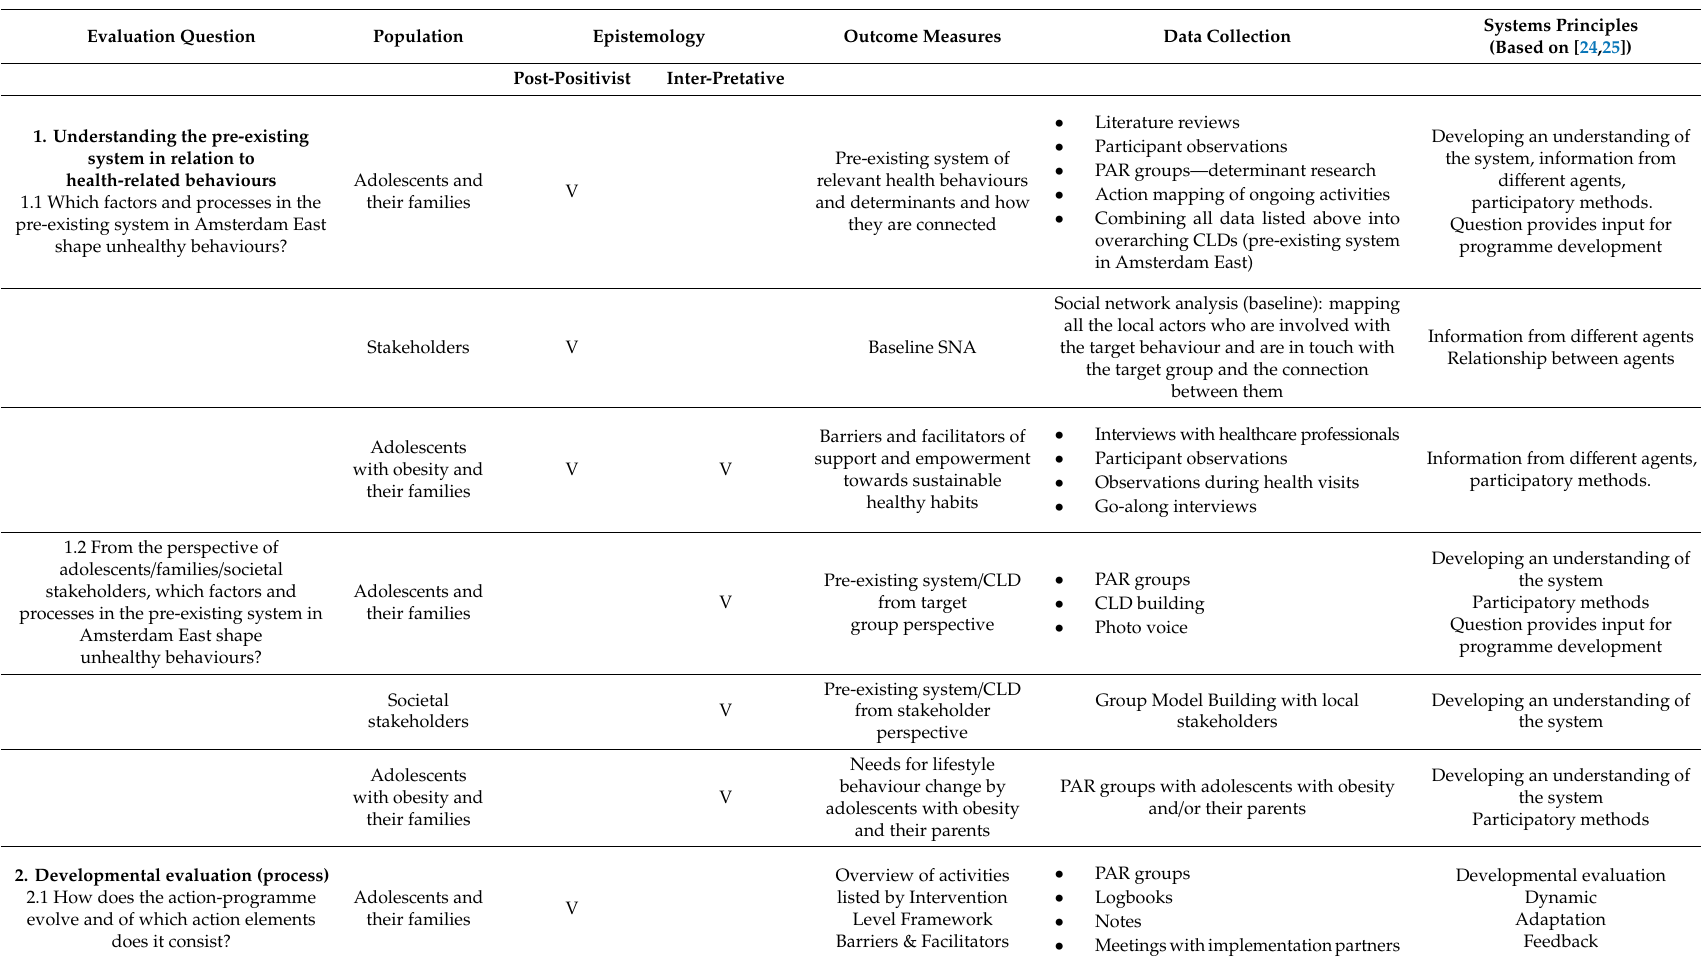
Table 1. An overview of the research questions, design and methodology of the LIKE developmental